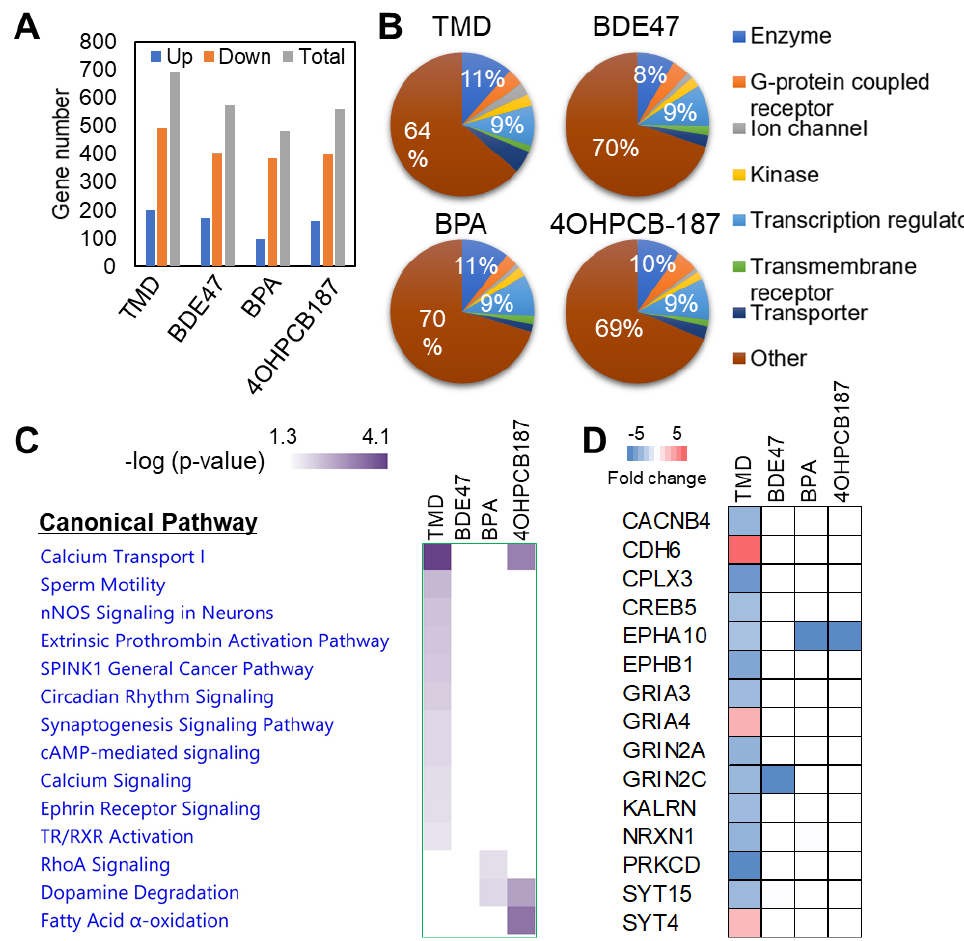
Figure 2. Transcriptome analysis of the effect of chemical exposure on gene expression in hESC-derived spheres. ( A ) Summary of the number and ( B ) functional annotation of differentially expressed genes in hESC-derived spheres after exposure to 1 μM TMD, 0.01 μM BDE47, 0.1 μM BPA, and 0.01 μM 4OH-PCB187. ( C ) Canonical pathway analysis of differentially expressed genes generated using the knowledge-based functional analysis software Ingenuity Pathways Analysis (IPA). ( D ) Expression of enriched genes involved in the synaptogenesis signaling pathway.